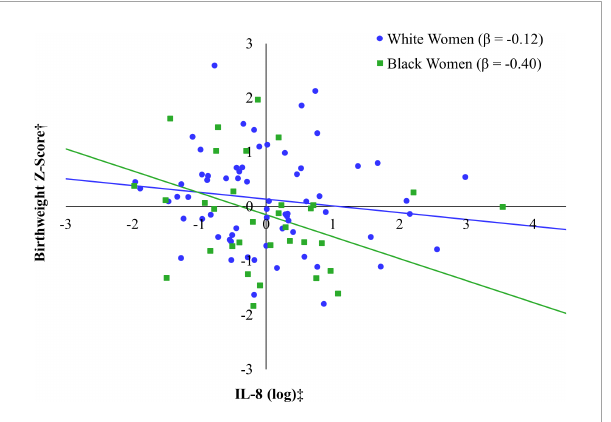
FIGURE 3 Relation between IL-8 (log) and birthweight Z-score by race*. *Models additionally adjusted for maternal age at the prenatal visit, maternal education, pre-pregnancy BMI (self-report), and PGH (log-transformed). † Birthweight Z-score accounts for gestational age at birth and fetal sex. ‡ IL-8 was log transformed.